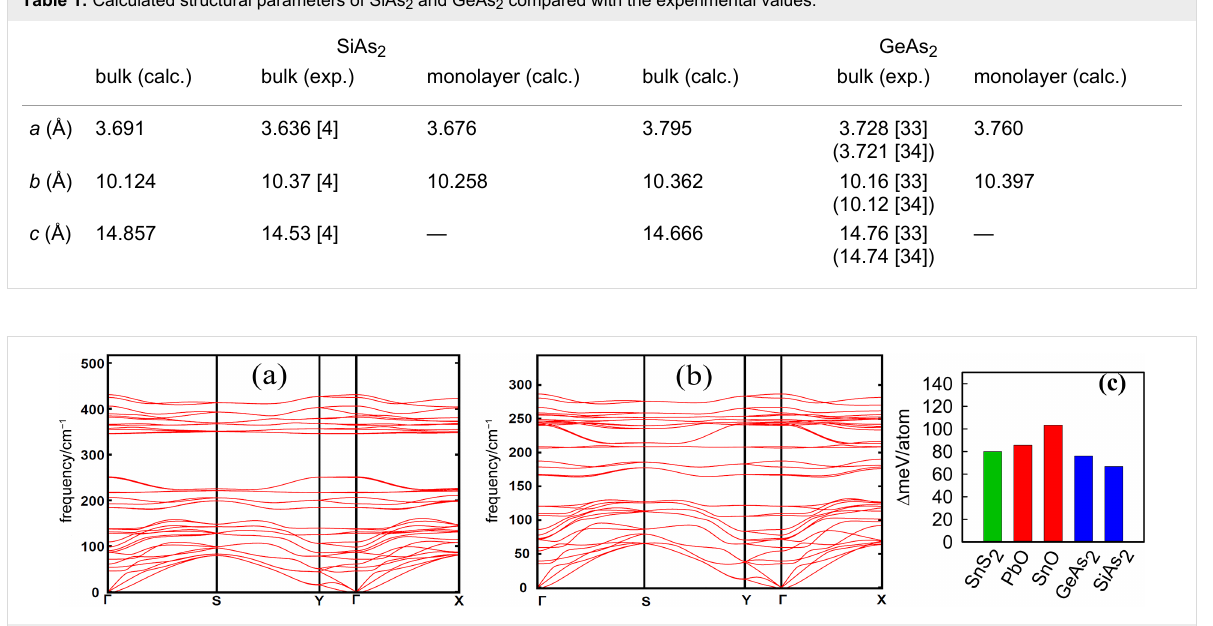
Figure 2: Phonon band structure of a monolayer of (a) SiAs 2 and (b) GeAs 2 along the high-symmetry points in the 1st Brillouin zone. (c) Energy of formation of the 2D material from its bulk counterparts (green: experimentally synthesized 2D compound, red: not experimentally synthesized 2D compound, blue: possibility to synthesize 2D compound theoretically shown).